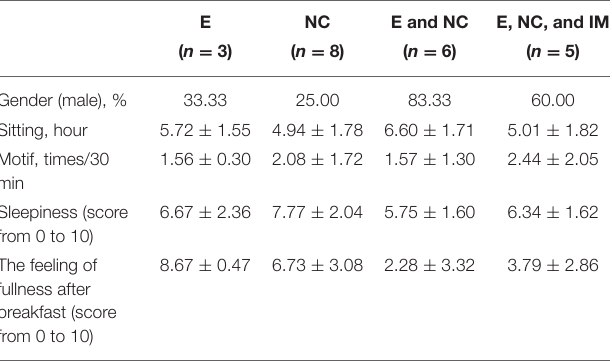
TABLE 2 | Characteristics by the change of LBP in each subject.